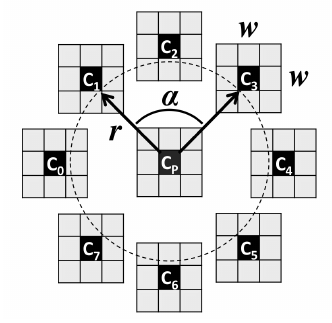
Figure 12. The Three-Patch LBP code with α = 2, w = 3 and S = 8 [87].